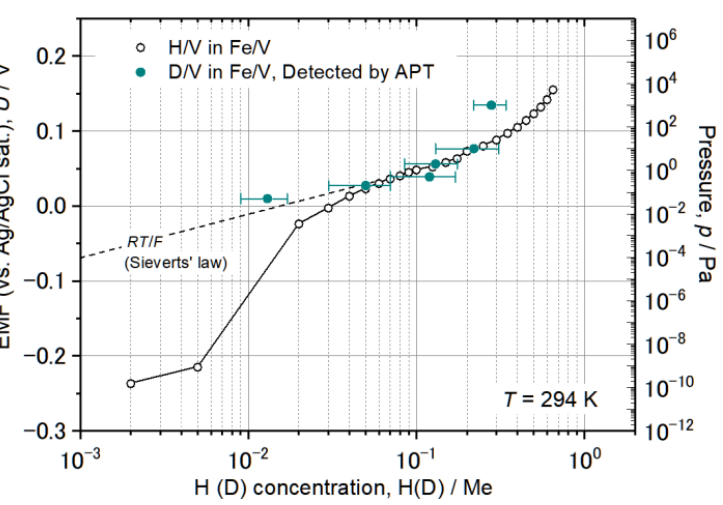
Figure 13. EMF curve of Pd 20 nm/[(Fe 5 nm/V 5 nm) × 8] deposited on Al 2 O 3 (0001) substrate at room temperature and individual c D determined by APT on the [Fe 2–5 nm/V 2–5 nm/Fe 2–5 nm] stack loaded at different D 2 pressure. The black dotted line RT / F shows the ideal solubility known as Sieverts’ law.